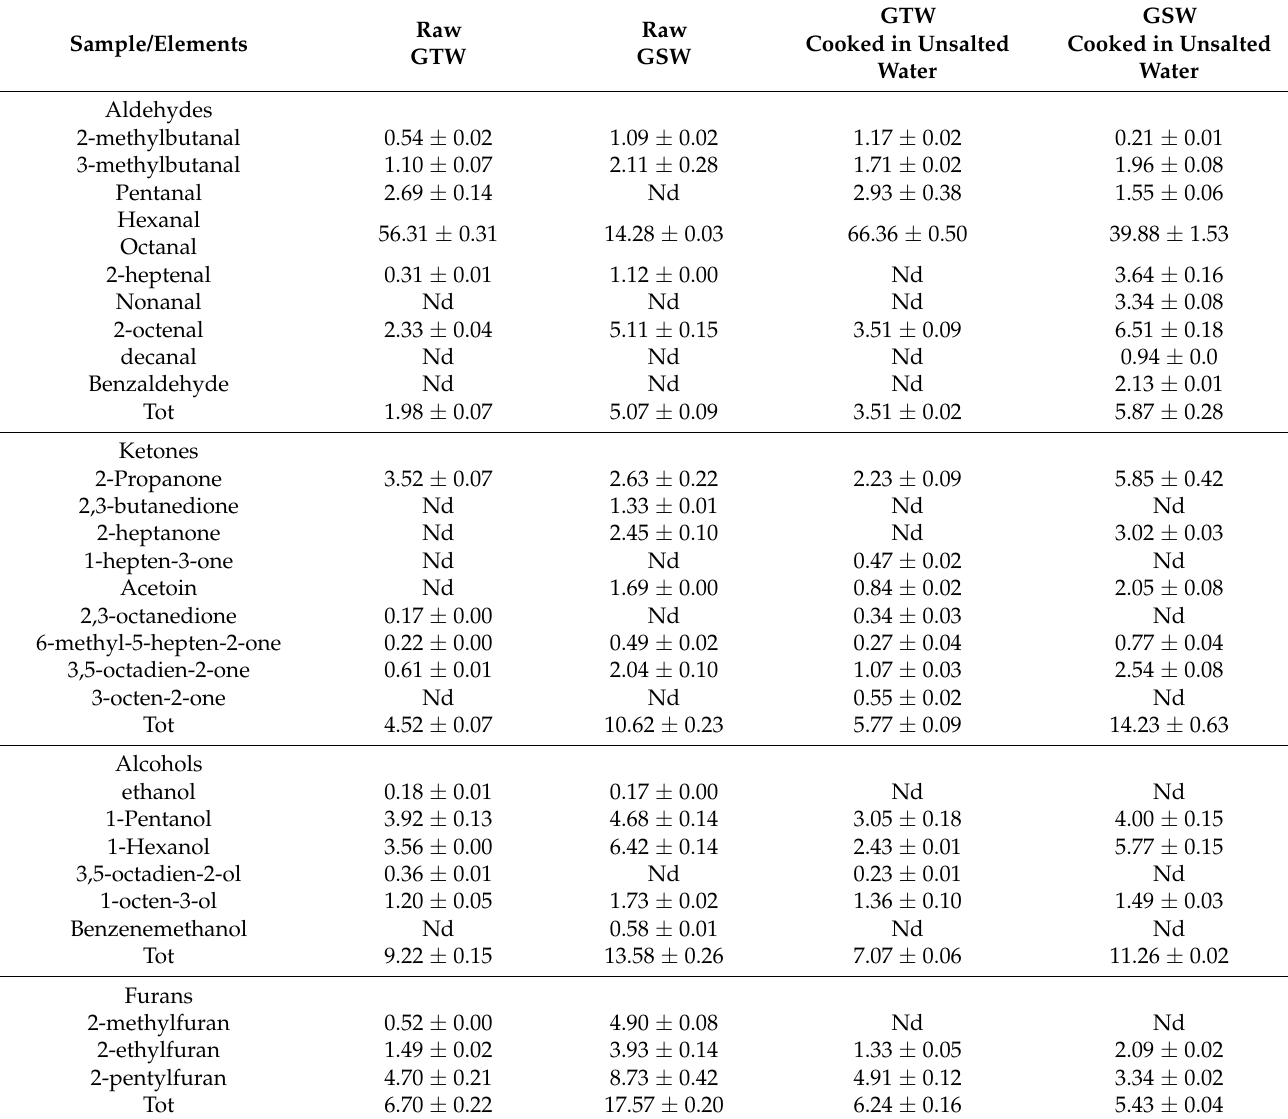
Table 3. Volatile organic compounds (VOCs) identified by SPME-GC/MS in Gnocchi